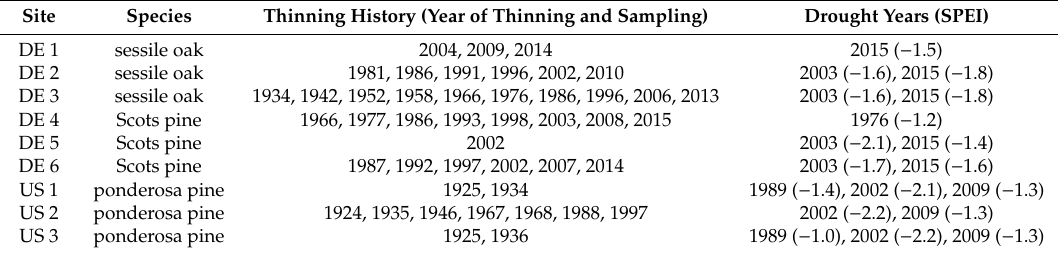
Table A1. Thinning history (year of thinning and subsequent sampling) and analysed episodic drought events (year of drought and corresponding mean SPEI value during the growing season in brackets) for each